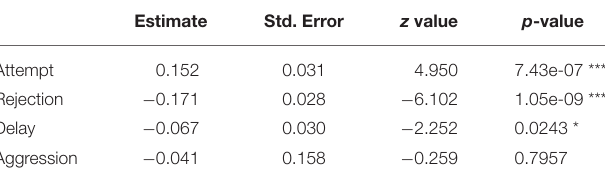
TABLE 3 | Table showing the outcomes of the generalized linear model (GLM).